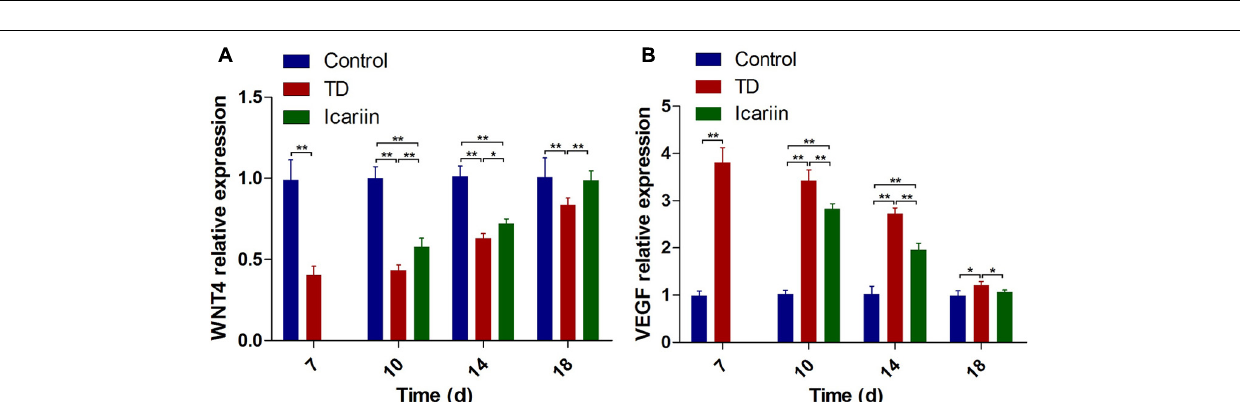
FIGURE 9 | RT-qPCR analysis of WNT4 and VEGF genes in growth plate cells was evaluated in control, TD, and icariin group chickens at 7, 10, 14, and 18 days. (A) The mRNA levels of WNT4 was detected by RT-qPCR. (B) VEGF mRNA levels detected by RT-qPCR. Correlation coefficient = target gene (average optical density)/reference gene (average optical density). The results are presented in arbitrary units as means ± SEM. ∗ P < 0.05, ∗∗ P <